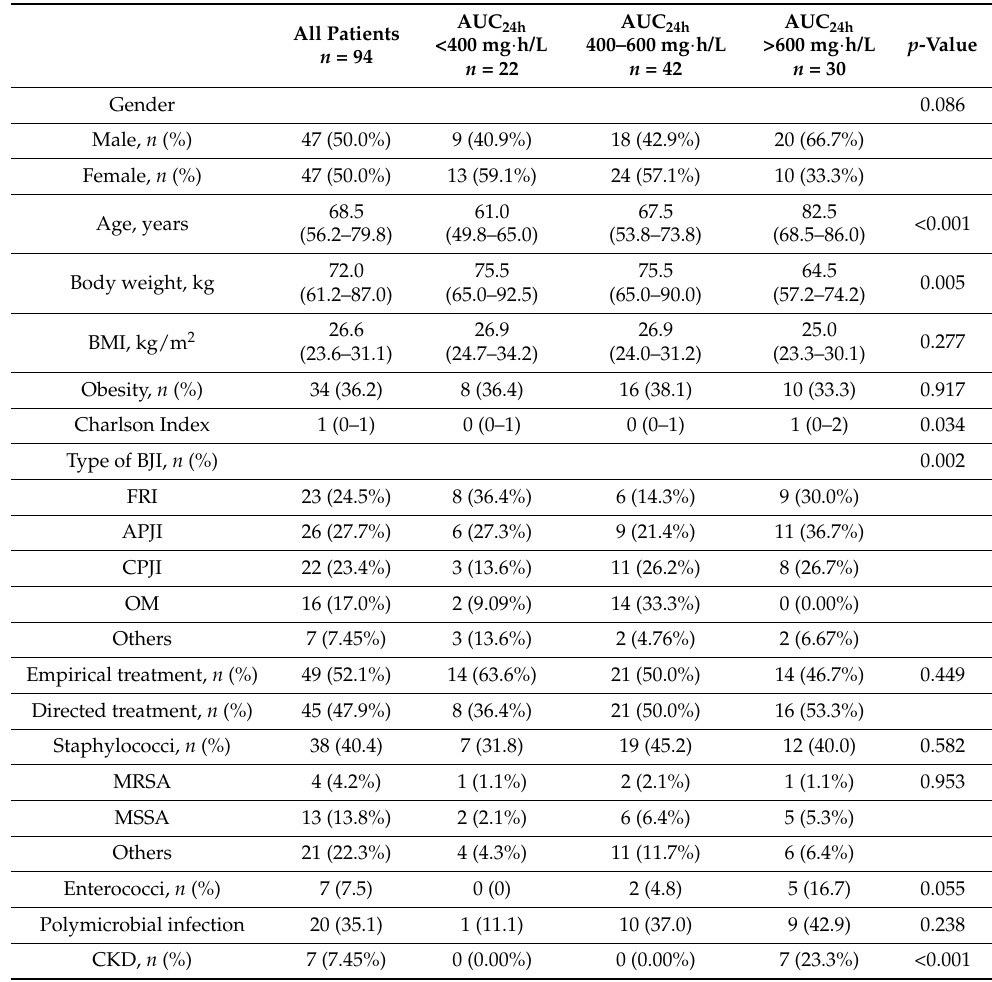
Table 1. Clinical and demographic data comparing patients with a suboptimal, optimal and suprather- apeutic PK/PD